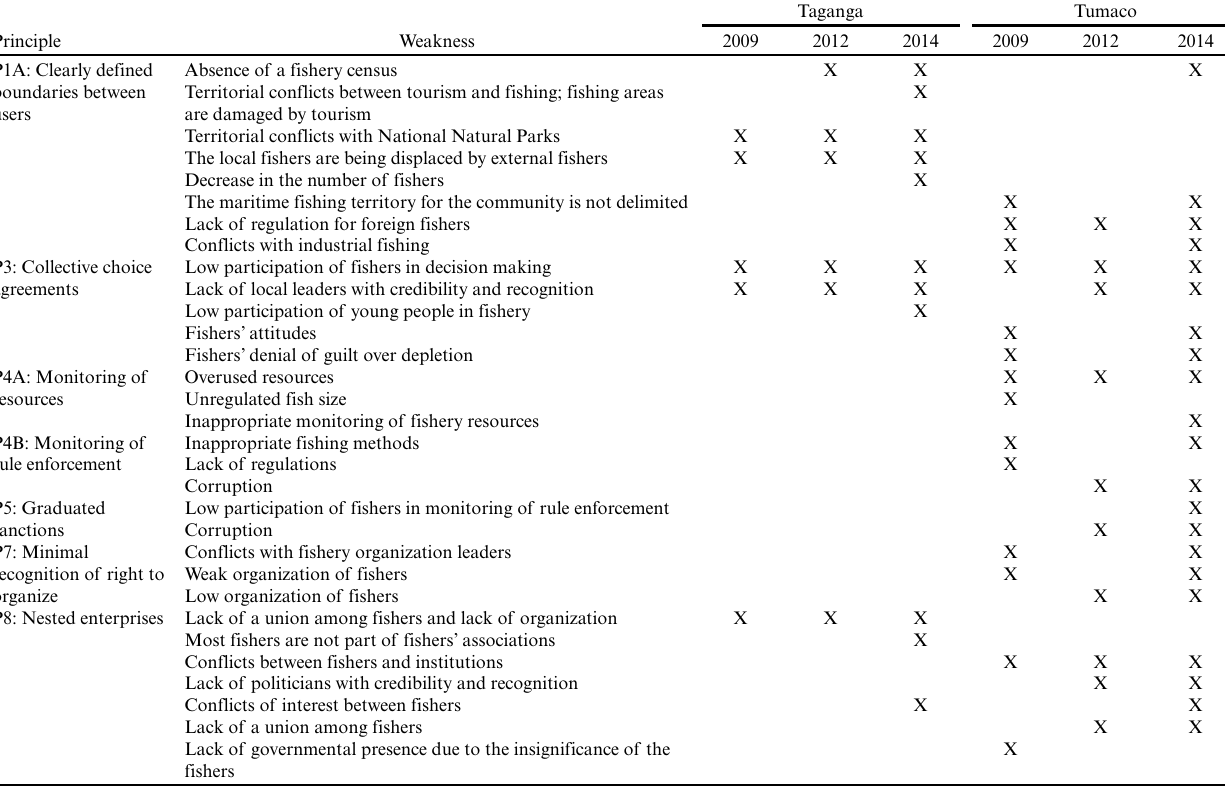
Table 2. Weaknesses identified by fishers in the case study communities based on the principles recommended by Ostrom (1990) to facilitate the comanagement of natural